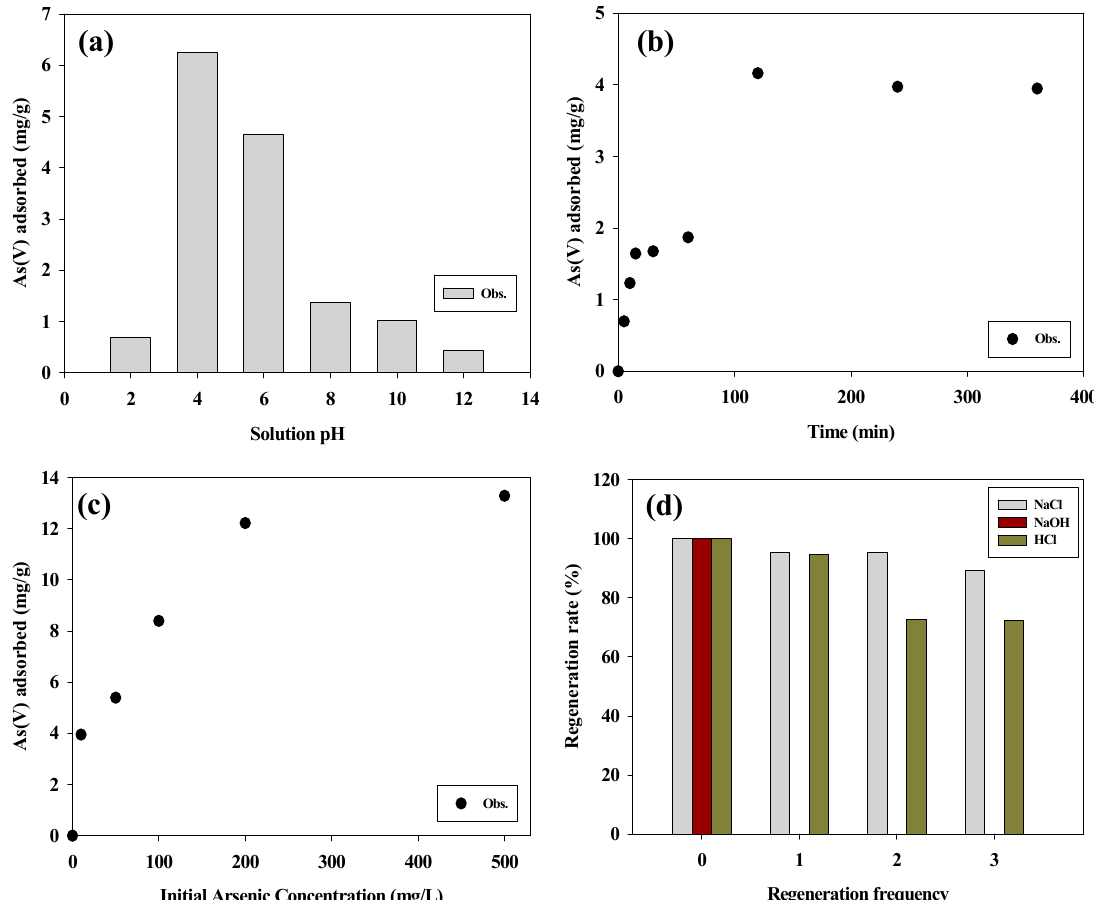
Figure 4. Effects of (a) solution pH (Dose = 2 g/L, initial concentration = 10 mg/L, reaction time = 6 h), (b) contact time (Dose = 2 g/L, initial concentration = 10 mg/L), and (c) initial As(V) concentration (Dose = 2 g/L, reaction time = 6 h) on As(V) removal by the ion-exchange fabric. (d) Regeneration efficiency during 3 reuse cycles with various regeneration solutions (Reaction time = 6 h, regenerant concentration = 0.1 M, regeneration time = 3 h).